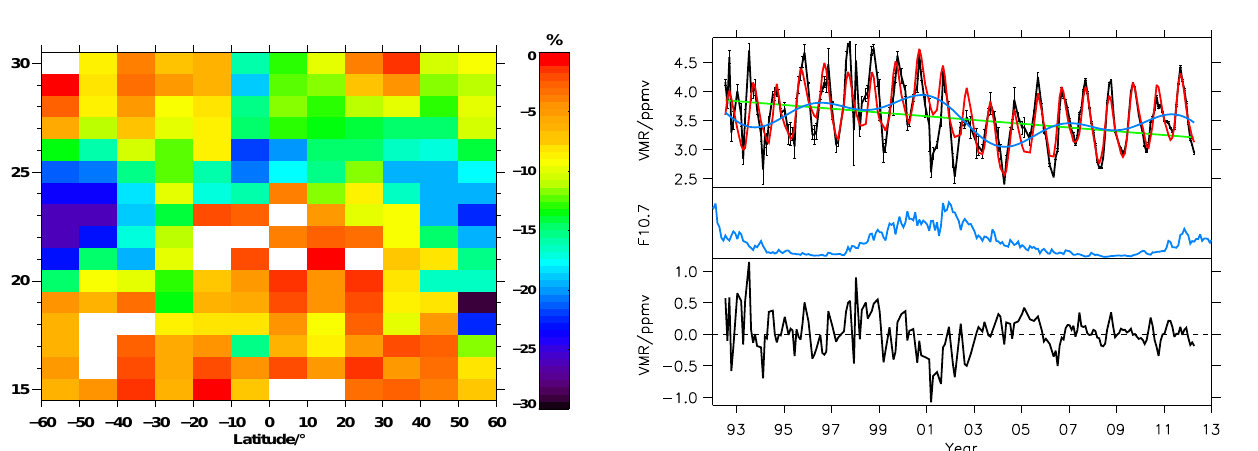
Figure 5. Top panel: Fitted regression model with solar cycle ap- proximated by harmonic parametrization as described under Ap- proach 1 in Sect. 4.2. The blue curve is the fitted contribution of these harmonics and the green line is the linear component. The middle panel (blue curve) shows the original solar cycle F10.7 parametrization in arbitrary units. In the lower panel the residual time series between the measured data and the fitted regression model is shown. The rms for this fit is 0.30 ppmv. For further details, see Fig.